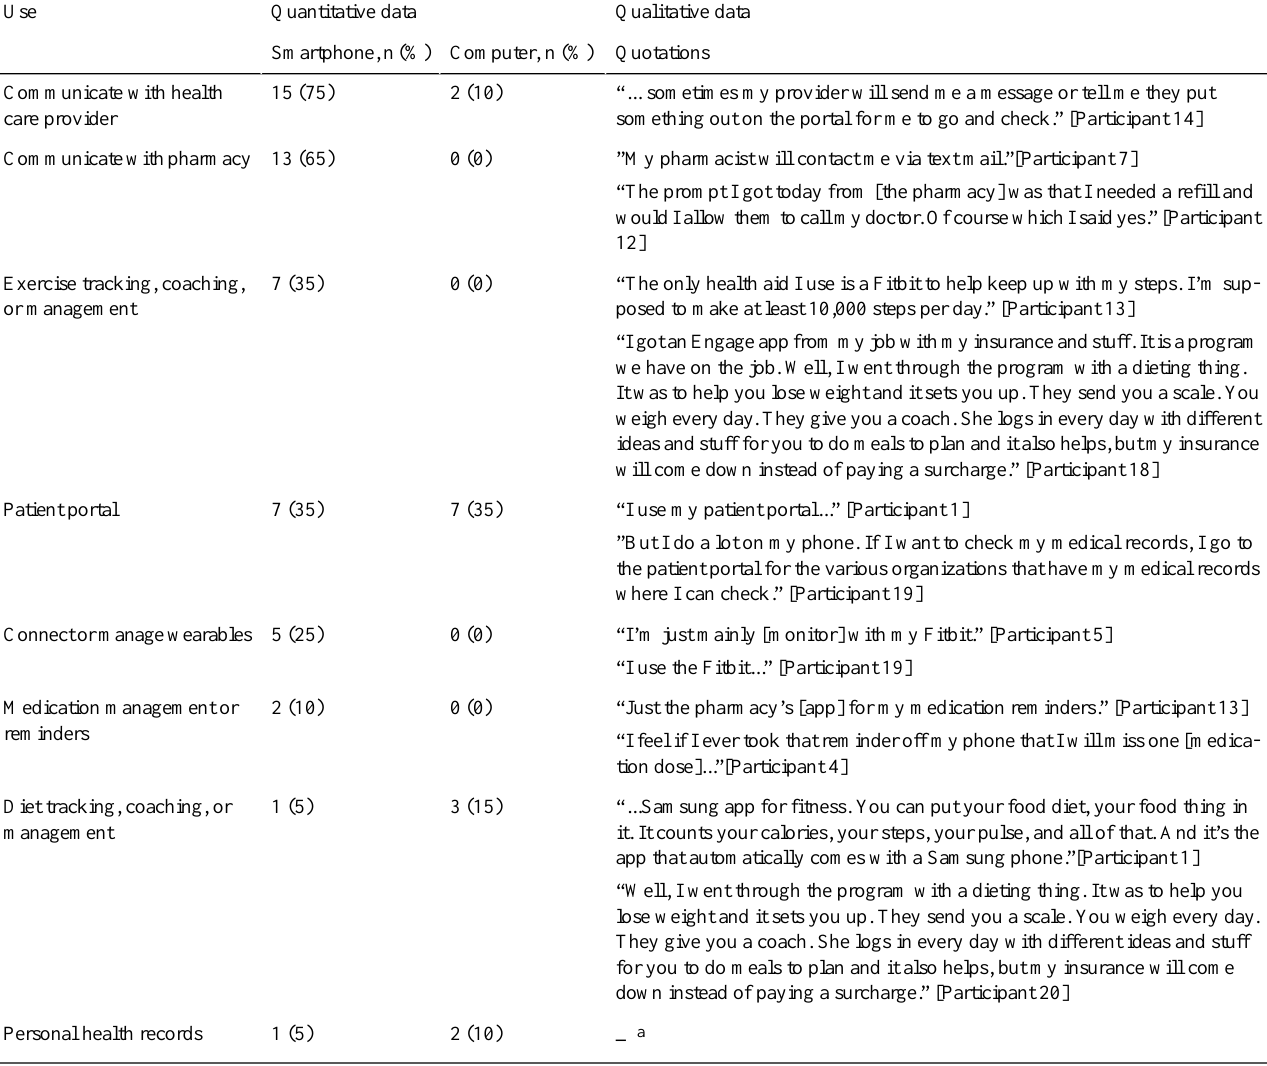
Table 2. Smartphone and computer use for health care.